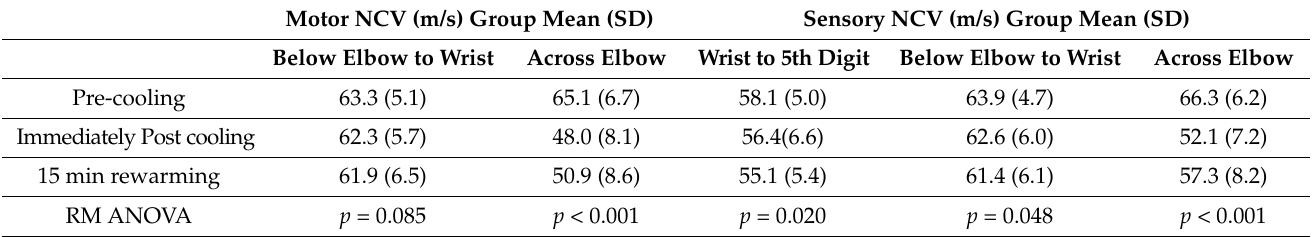
Table 1. Descriptive statistics and RM ANOVA for NCV.